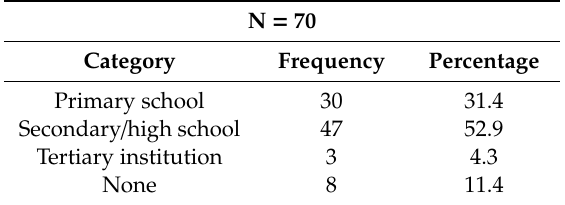
Table 1. Level of education in the Makwane community during the study period.